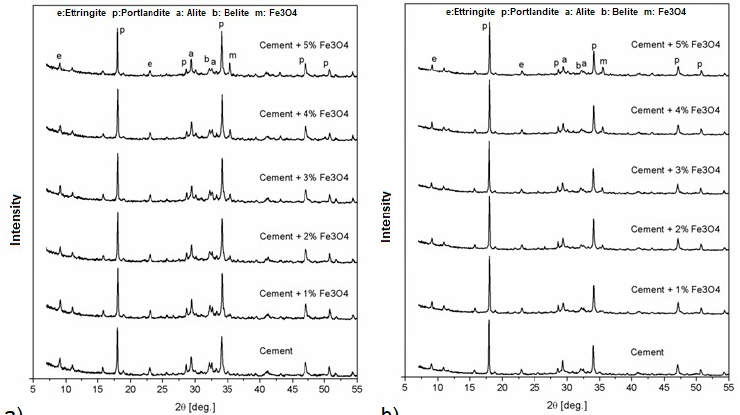
Figure 10. Heat flow calorimetry of the cement paste (0.5 wt %) with different dosages of nano-Fe 3 O 4 (Reprinted with permission from [40]).